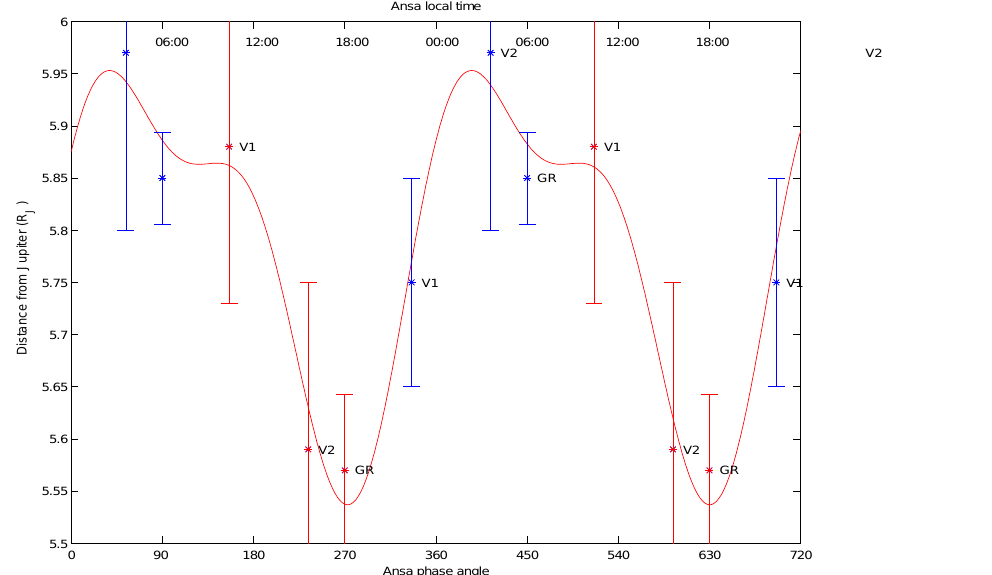
Figure 6. Average location of the ansae as a function of ansa angle and local time. The ansa angle is defined similar to the Io phase angle, the ansa at midnight has zero and the ansa at noon has 180 ◦ angle. The approaching ansa are shown in blue and receding ansa in red. The solid red line is a second order Fourier fit to the